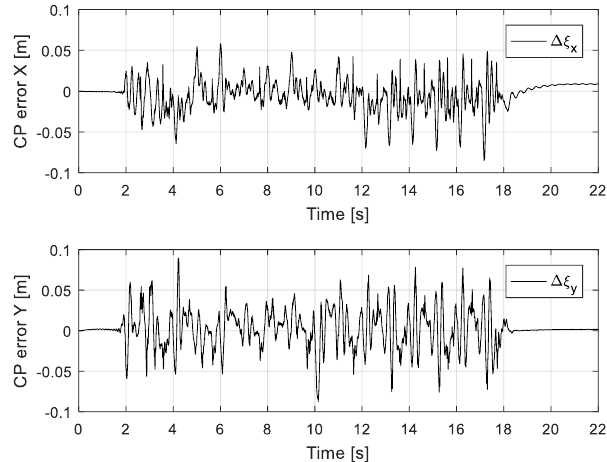
Figure 18. Measured capture-point error along x and y directions.